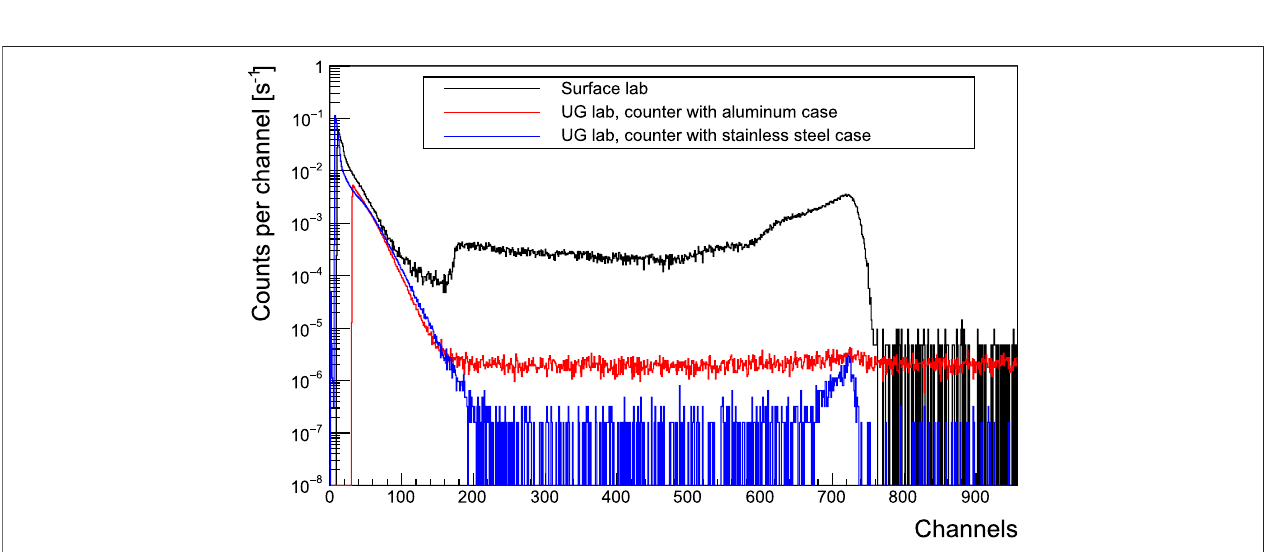
FIGURE3 | Comparison ofneutron backgroundmeasuredby means of 3 He counters: the black oneis measured inasurface laboratory.Blue and red spectra are measured in the LNGS underground laboratory by means of counters with stainless steel and aluminum cases, respectively.